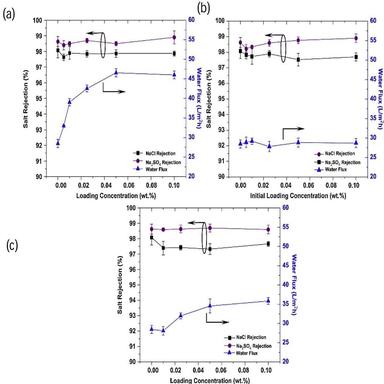
Salt rejection and water flux through the (a) M-TFN membrane, (b) M-TFN membrane but the nanoparticles were taken out before the IP reaction and (c) membrane with non-porous silica TFN.